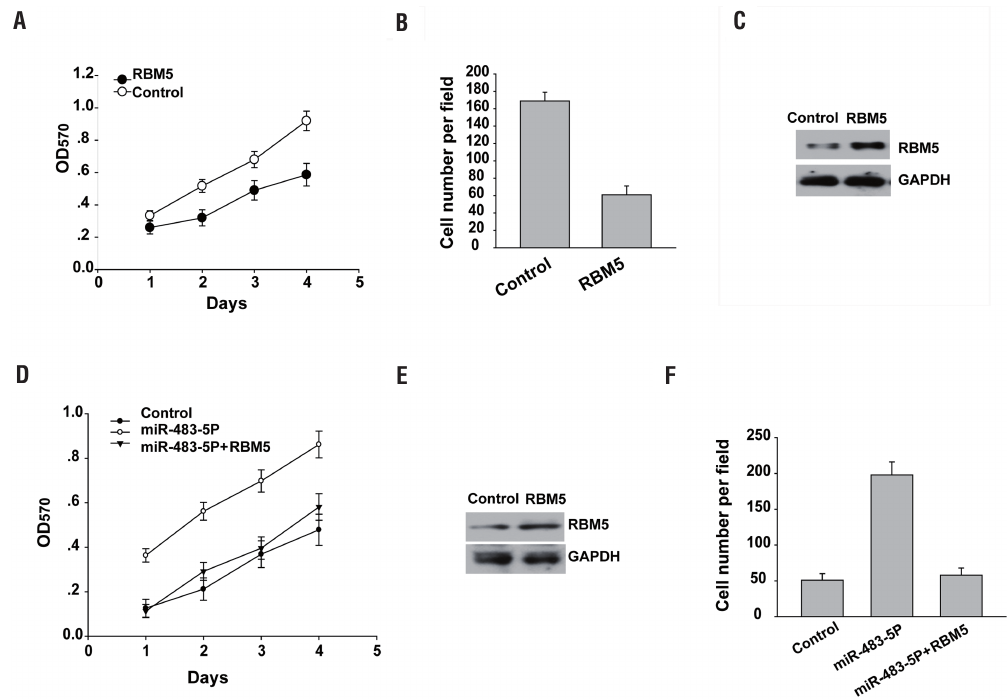
figure 4 - Enforced RBM5 expression mitigates miR-483-5p promotion of prostate cancer cell growth and invasion. (A) MTT assay was performed after transfection of Lncap cells for 1 to 4 days. (B) Invasion assays were used to determine Lncap cell motility. The invaded cell numbers were quantified 24h after cells were seeded. Data are presented as mean±sD from three independent experiments. (c) western blot analysis of RBM5 levels in the fourth day was examined. GApDh was also determined as a loading control. (D) MTT assay was performed after transfection of Lncap cells for 1 to 4 days. (E) western blot analysis of RBM5 levels in the fourth day was examined. GApDh was also determined as a loading control. (f) Invasion assays were used to determine Lncap cell motility. The invaded cell numbers were quantified 24h after cells were seeded.